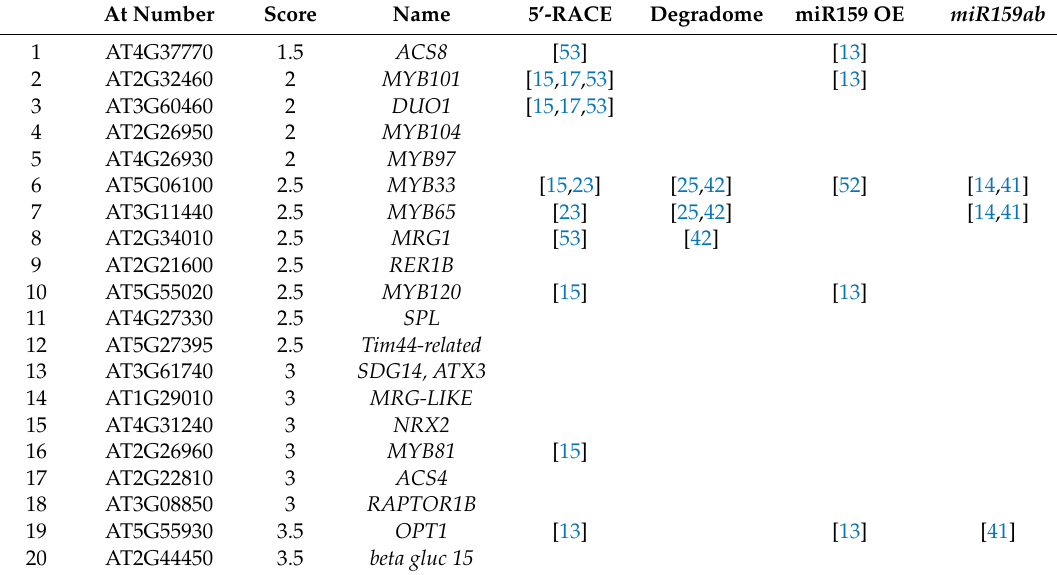
Table 1. miR159 targets in Arabidopsis as determined by di ff erent approaches. The top 20 miR159a targets in Arabidopsis as identified by the bioinformatic program psRNATarget with standard search parameters [40]; the number of mismatches is indicated by the score. Confirming this prediction, 5 (cid:48) -RACE analysis can detect miR159-guided cleavage products for at least nine of these genes. In contrast, the more quantitative degradome analysis only identifies three of these genes, with only MYB33 and MYB65 being frequently detected in multiple degradome analyses [25,42]. Overexpression of miR159 could detect down-regulation of multiple targets [13,52]. However, genetic analysis using a loss-of-function mir159ab mutant identify MYB33 and MYB65 as the major important targets [14,41]. At Number